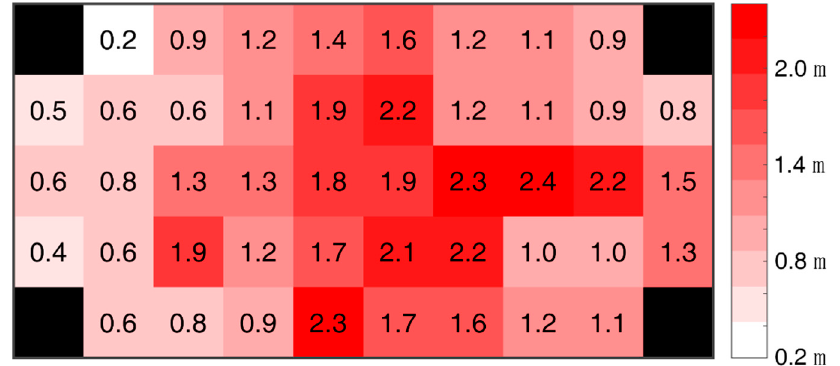
Figure 10. Heatmap of positioning mean absolute error (MAE).